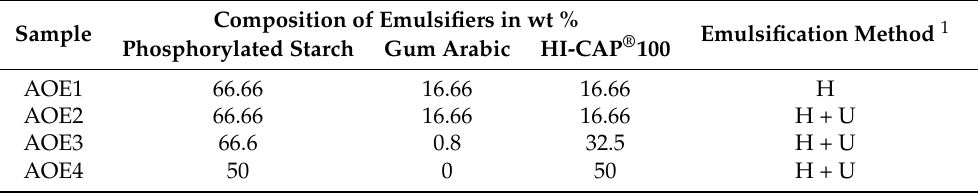
Table 1. Formulation and composition of avocado oil-in-water emulsions by using different biopolymers.